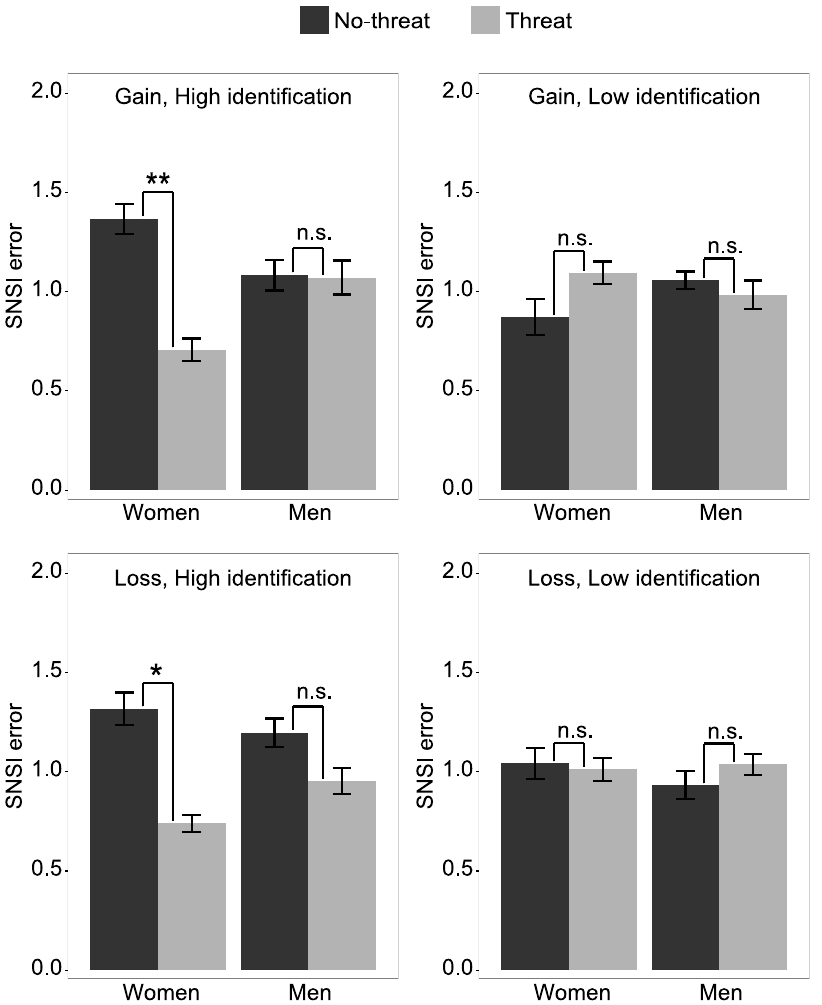
Fig 3. SNSI errors. Mean SNSI errors across participants, as a function of treatment (threat vs. no-threat), sex, frame (gain vs. loss) and identification (high vs. low). Error bars reflect 95% CI intervals. � : p < .05, �� : p < .01 (corrected for 2 comparisons); ns: p >